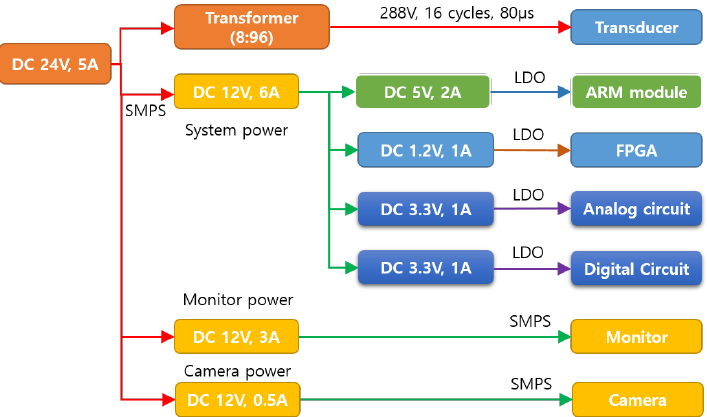
Figure 4. The block diagram of power supply of